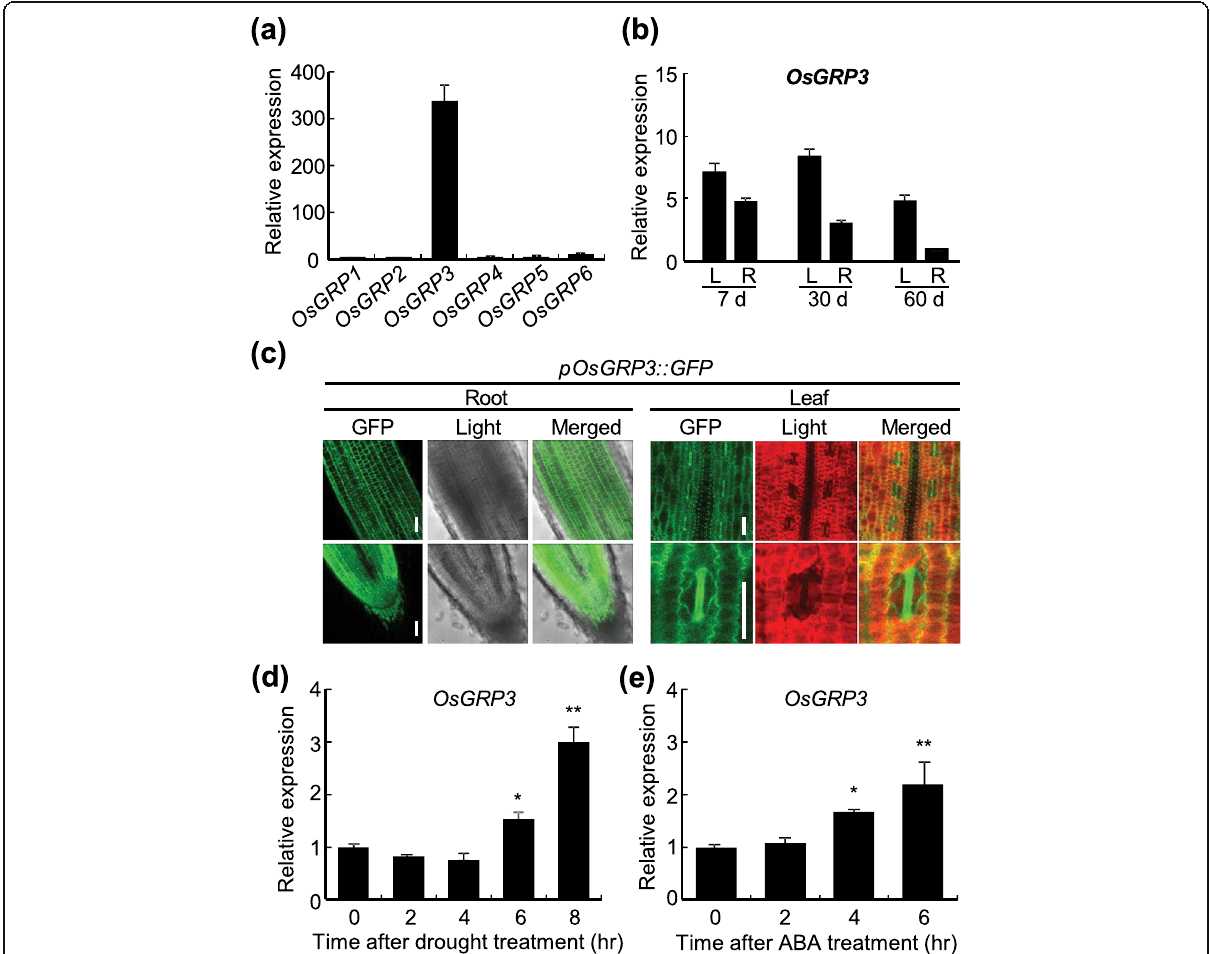
Fig. 1 Expression of OsGRP3 in rice plants under drought conditions. a qRT-PCR analysis was performed for measuring endogenous expression levels of six annotated OsGRP s using RNAs extracted from leaves of two-week-old rice seedlings. b Expression levels of OsGRP3 in leaves and roots of rice plants at different developmental stages were analyzed using qRT-PCR. Rice UBIQUITIN ( OsUBI ) was used as an internal control for normalization. a and b Data represent the mean value ± standard deviation (SD) ( n = 3, biological replicates). c The activity of OsGRP3 promoter was analyzed by detecting GFP fluorescence in two-week-old pOsGRP3::GFP transgenic plants. Bar = 30 μ m. Two-week-old rice seedlings were exposed to d drought stress and e 0.1 mM ABA. Leaves of rice seedlings were harvested at an indicated time points after the treatments. Rice UBIQUITIN ( OsUBI ) was used as an internal control for normalization. d and e Data represent the mean value ± standard deviation (SD) ( n = 3, biological replicates). Asterisks indicate a statistically significant difference compared with 0 h. * P < 0.05, ** P < 0.01; One-way